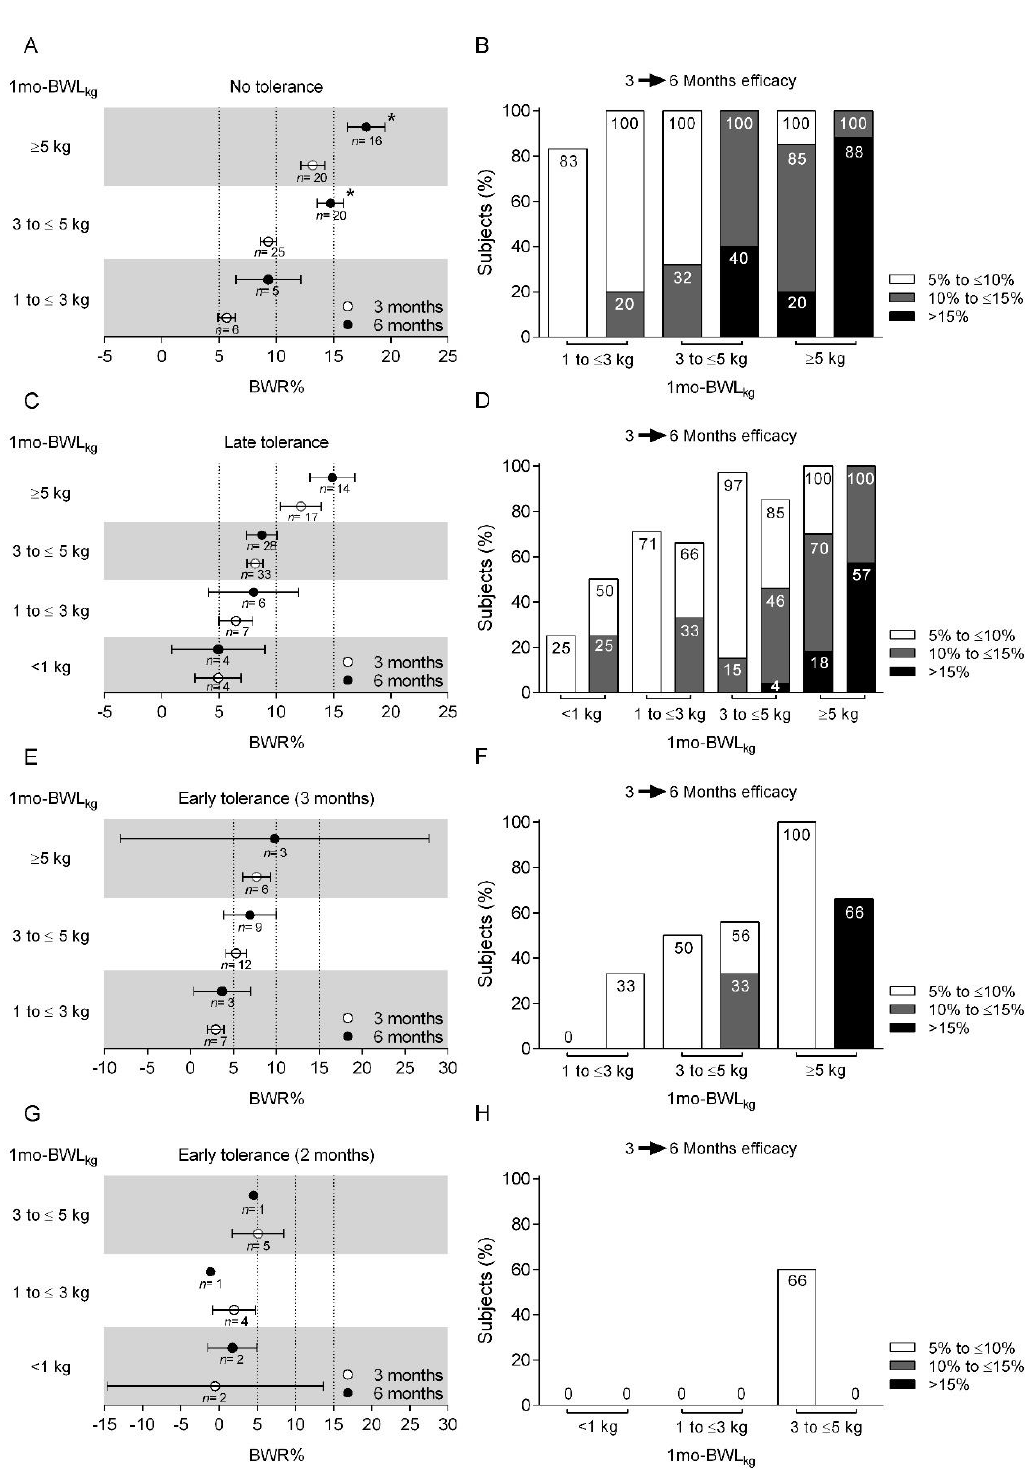
Figure 3. Three- and six-month mean percentage body weight reduction (BWR%) efficacy of 30 mg phentermine, according to body weight loss in kilograms during the first month (1 mo-BWL kg ) and development of tolerance to phentermine. Tolerance was divided into no tolerance ( A , B ), late tolerance ( C , D ), tolerance at month 3 ( E , F ), and tolerance at month 2 ( G , H ). Each point represents the mean BWR% value and bars represent 95% confidence intervals ( A , C , E , G ) or the percentage of subjects who achieved a % interval of efficacy ( B , D , F , H ). * Significantly different by Student’s t -test ( p < 0.05).